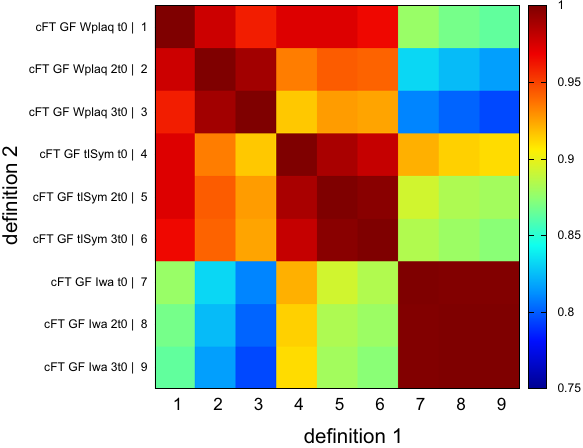
Fig. 15 Comparison of field theoretic definitions with GF smoothing anddifferentsmoothingactionsandflowtimes.Thecorrelationbetween different definitions is colour-coded (note the scale is different than in Figs. 9, 10, 16, 14)